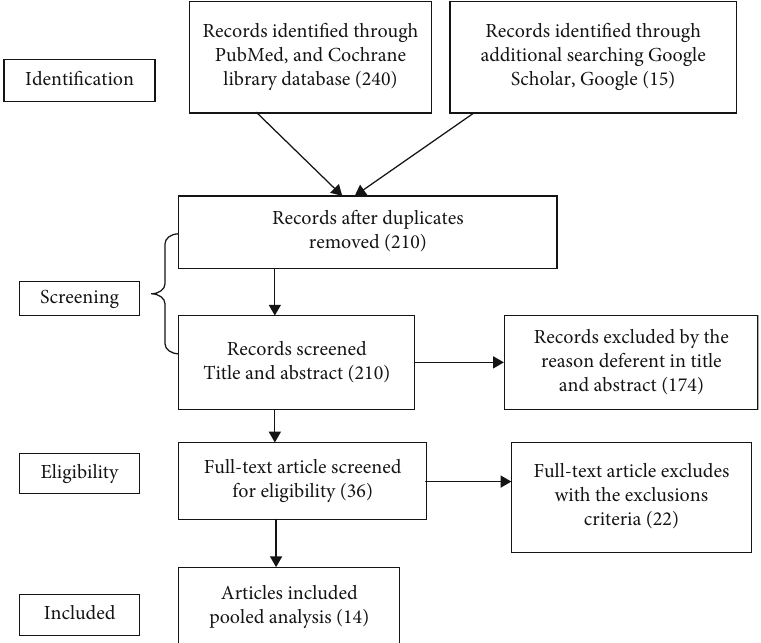
Figure 1: PRISMA fl ow diagram summarizing the literature